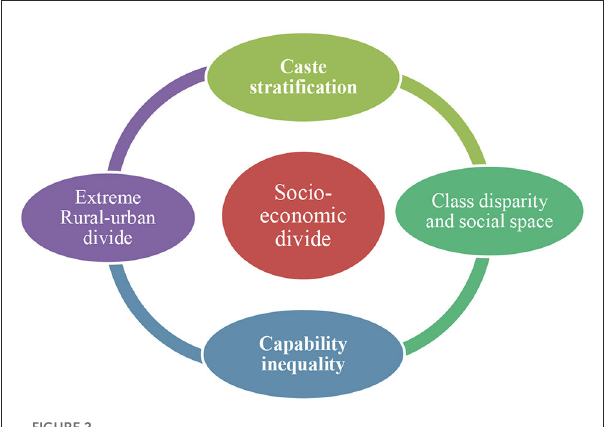
FIGURE2 The interface of the socioeconomic and digital divides in India. Source: A field study in village and city in Assam,